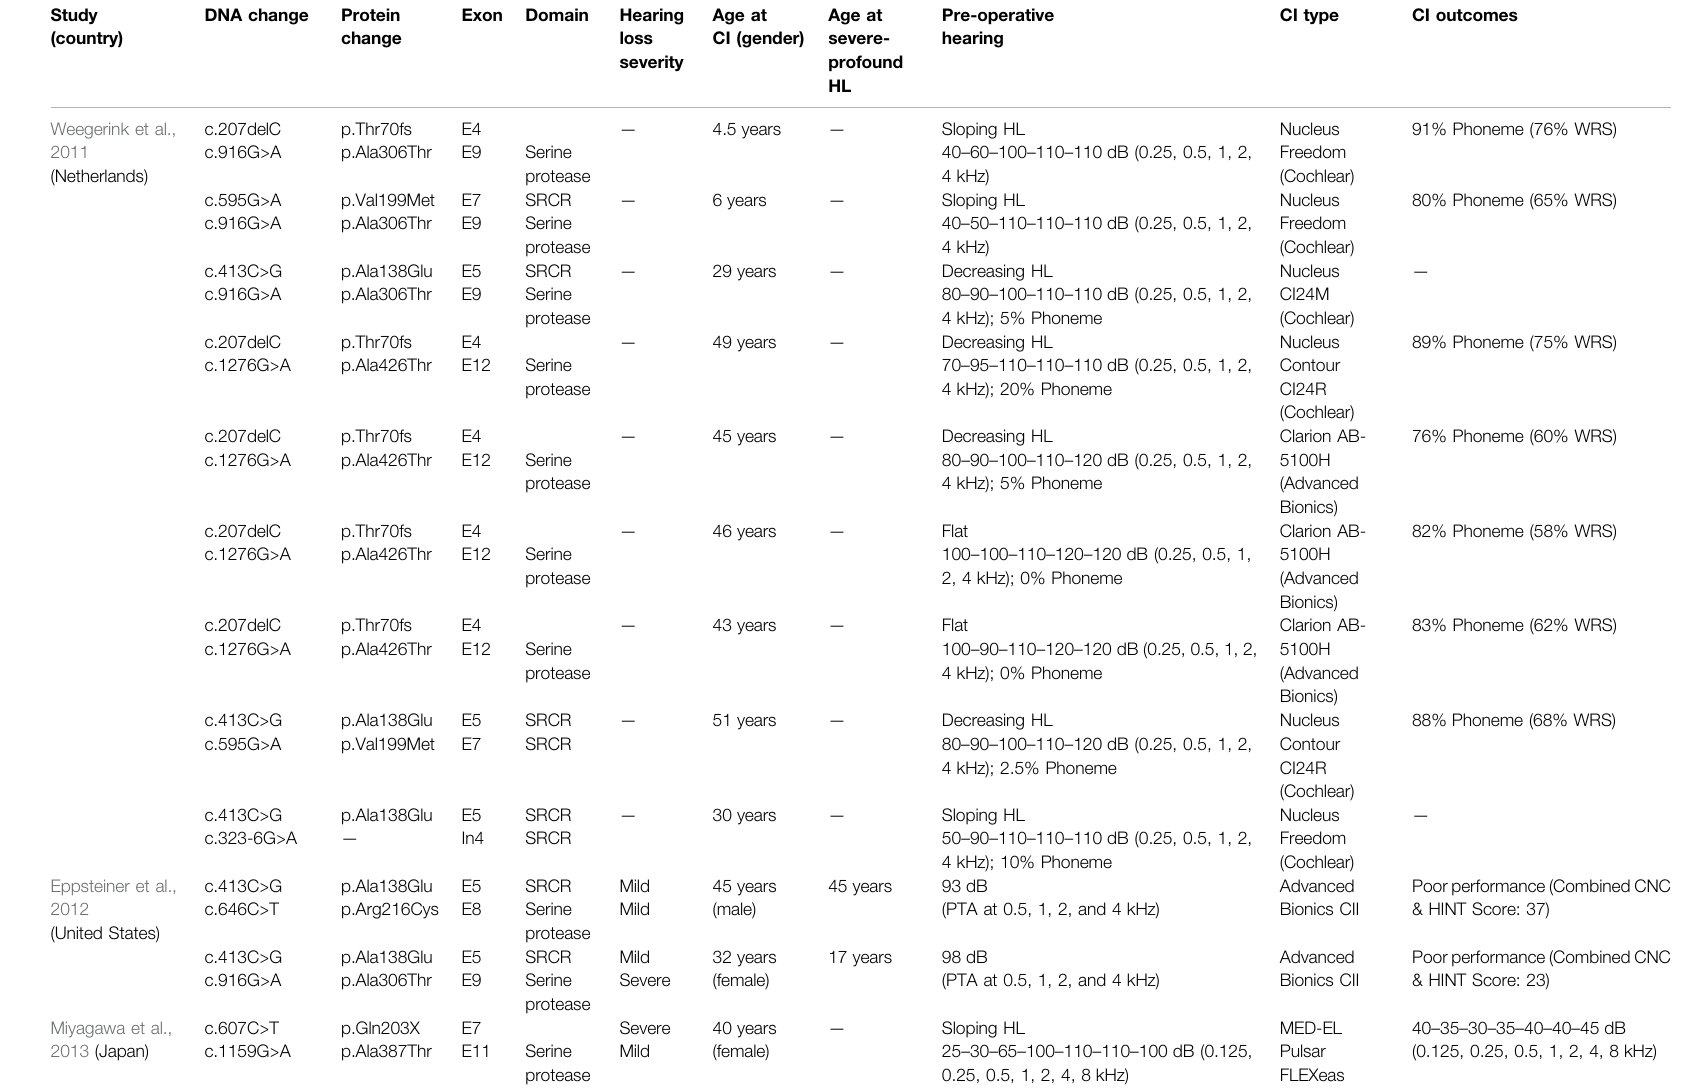
CI type CI outcomes